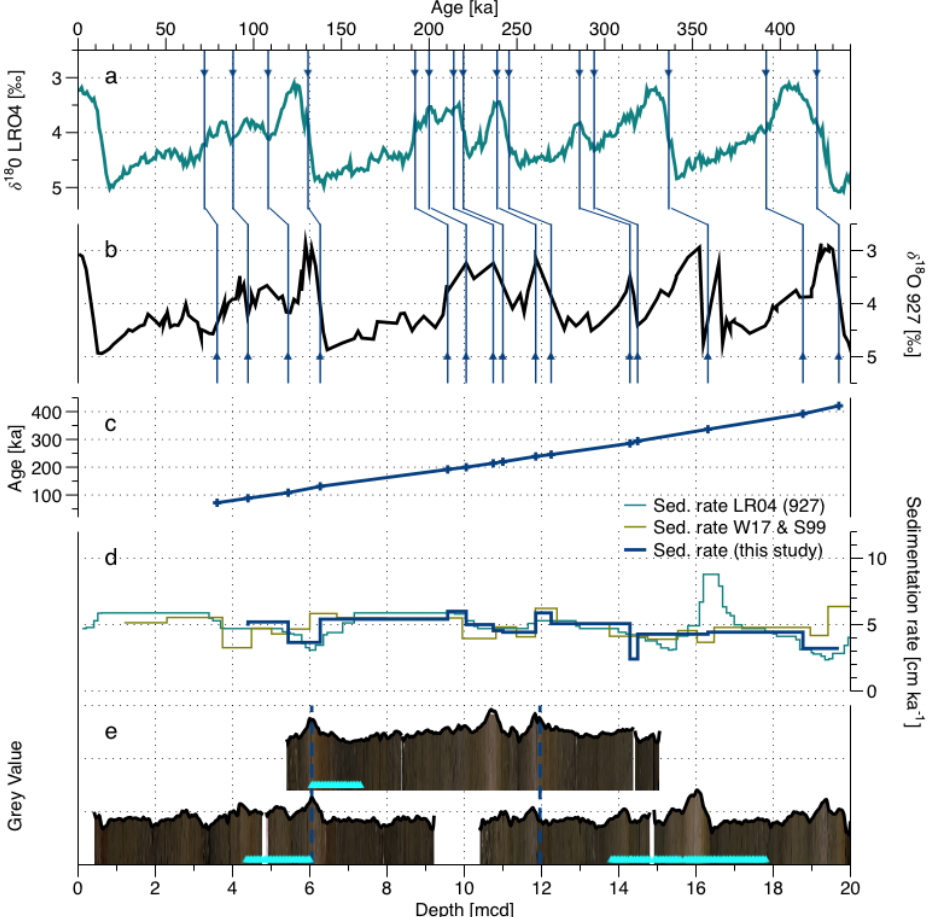
Figure 5. Depth–age correlation for the late Pleistocene, cores 927A 1H, 927B 2H and 927A 2H (following the splice) with (a) the Lisiecki and Raymo (2005) δ 18 O stack; (b) the local δ 18 O record (Wilkens et al., 2017, modified from Bickert et al., 2004); (c) the age–depth record with control points; (d) the SR from Wilkens et al. (2017) (green), the SR using the LRO4 depths and ages for site 927 (blue-green), and the SR defined in this study (blue); and (e) the core images (Wilkens et al., 2017) and grey value record for the three cores of the splice used, the position of the switch from one core to the other in the splice (dashed lines), and the position of the samples used in the present study in the cores (light blue